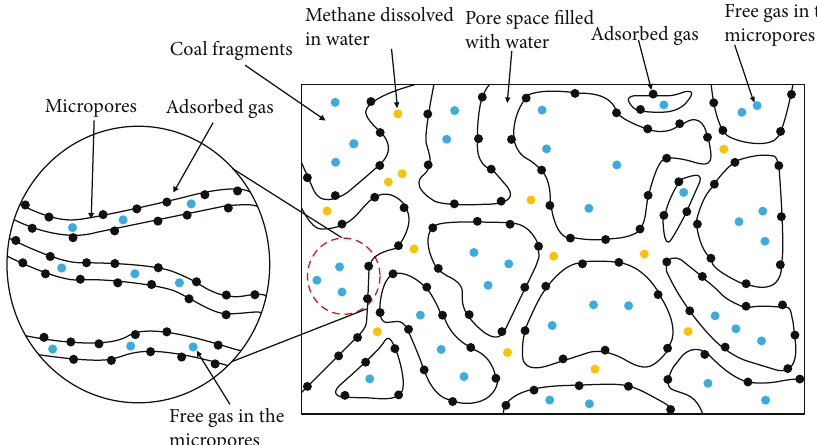
Figure 1: Diagram of coalbed methane storage in the reservoir.